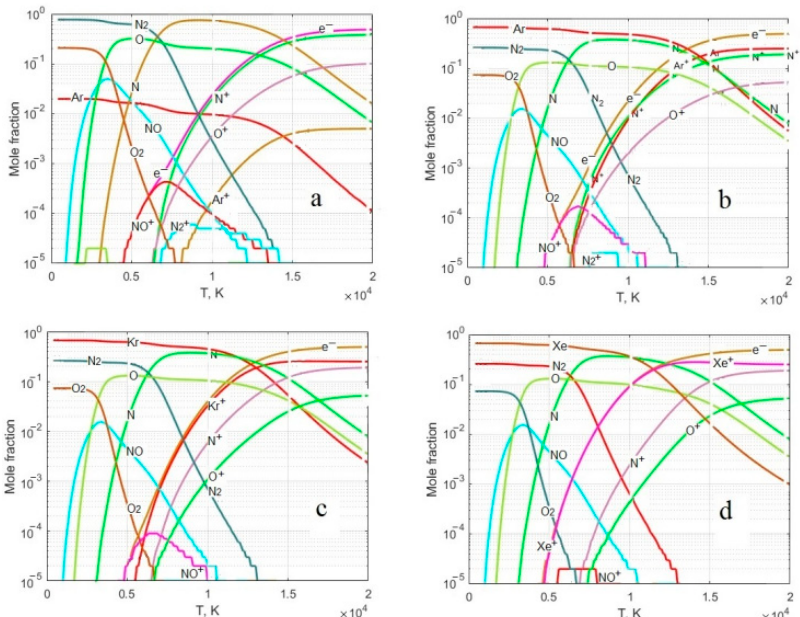
Figure 8. The equilibrium composition of: ( a ) air (N:O:Ar = 78:21:1) and its mixtures; ( b ) N:O:Ar